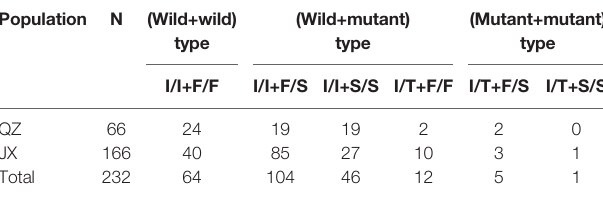
N indicates the sample number.